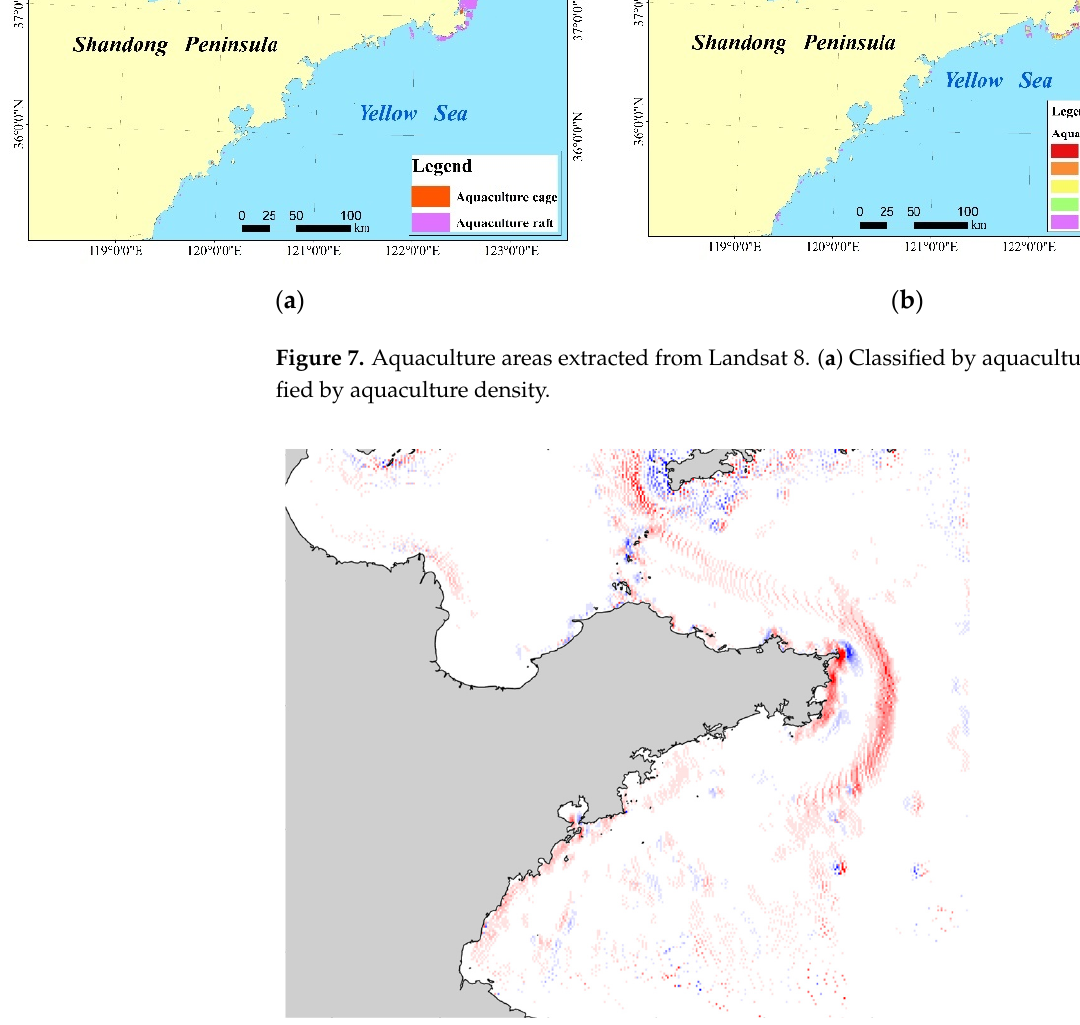
Figure 7. Aquaculture areas extracted from Landsat 8. ( a ) Classified by aquaculture type; ( b ) Clas- sified by aquaculture density.